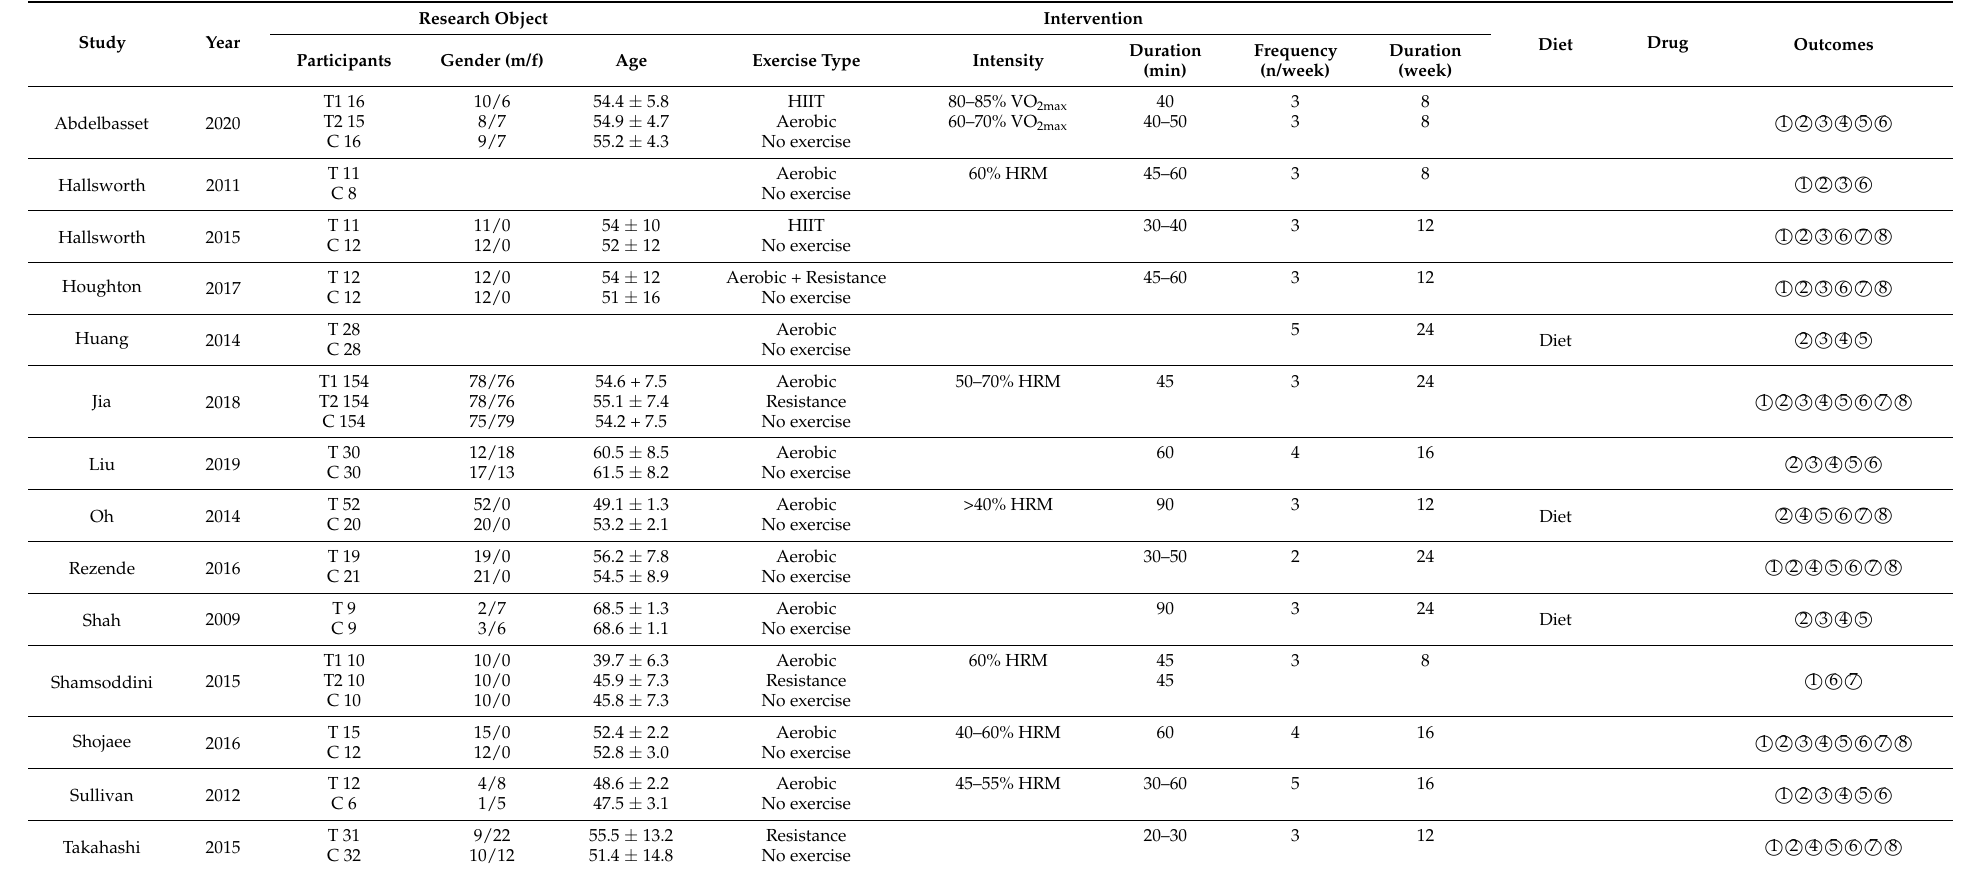
Table 1. Characteristics of the included